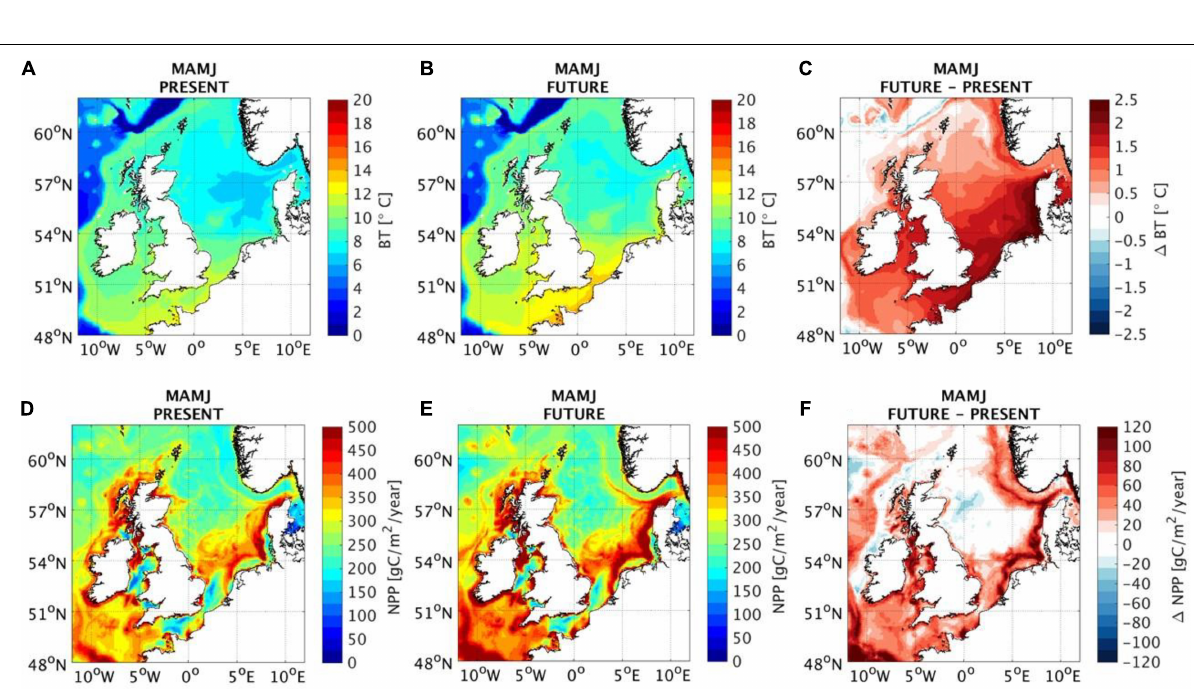
Frontiers in Marine Science |